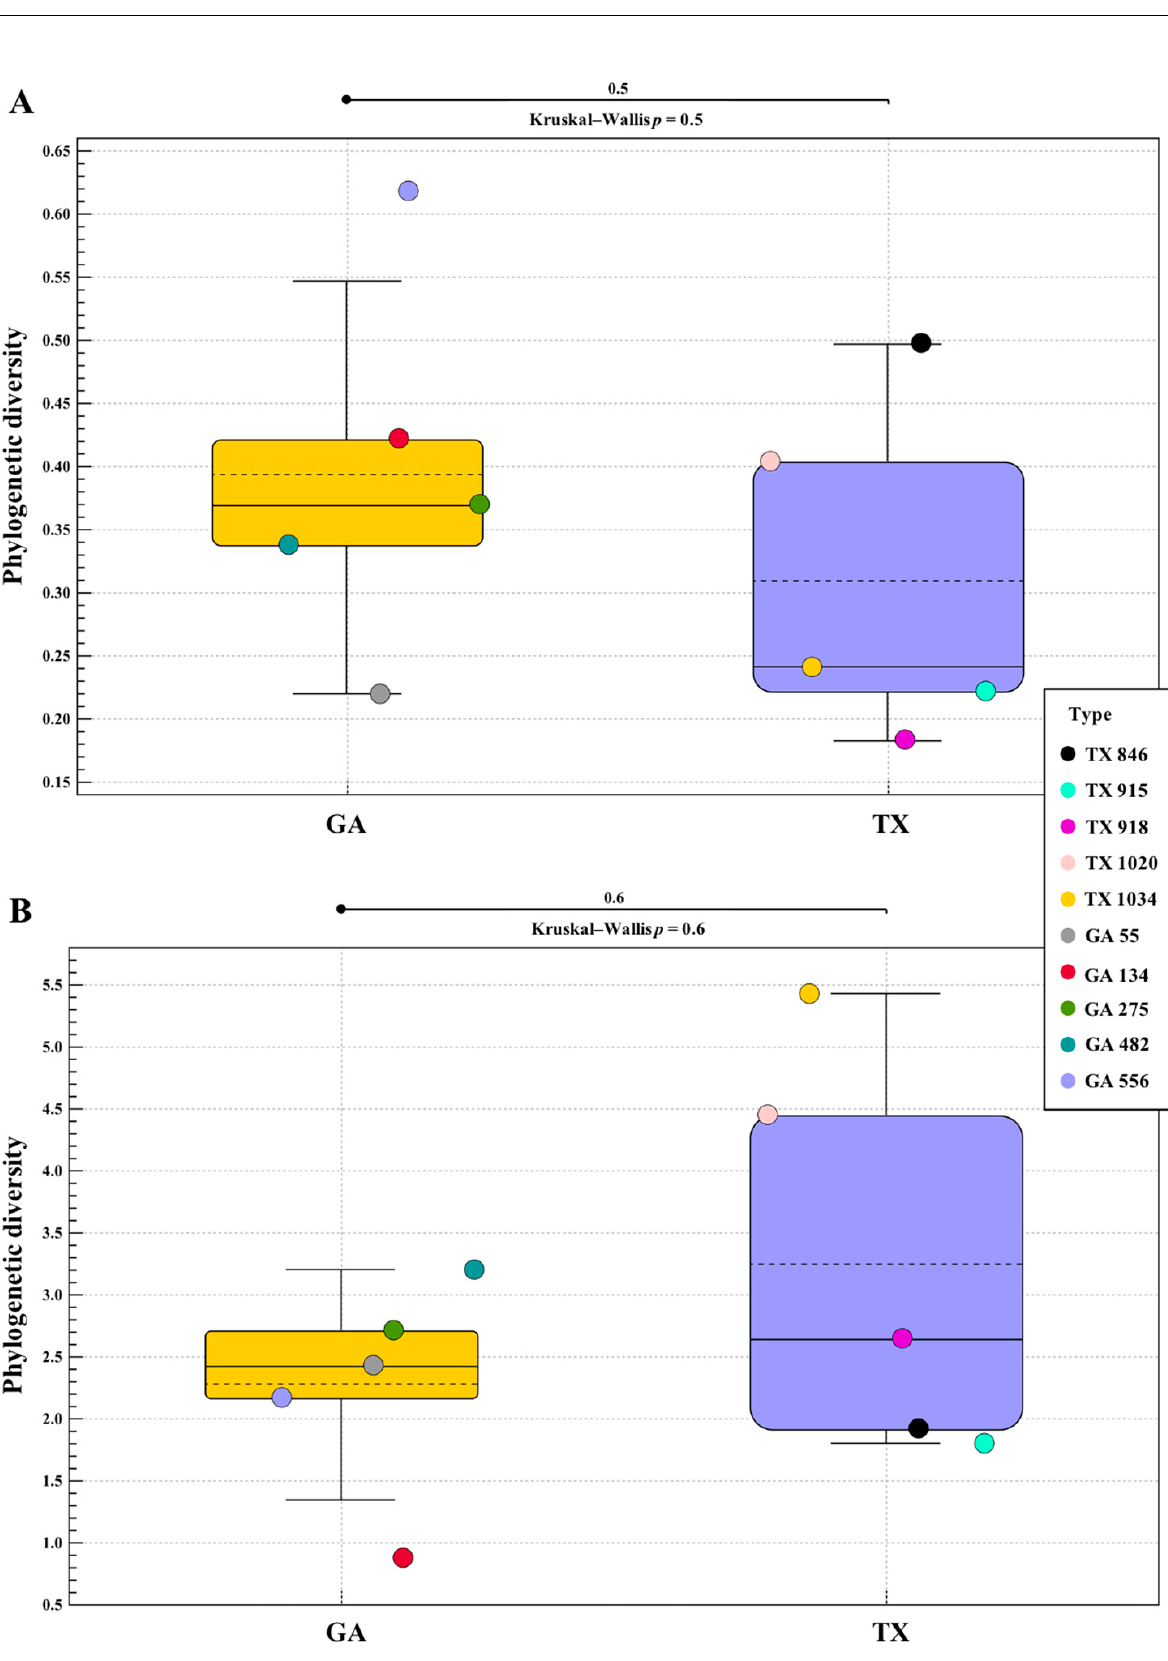
Figure 2. 16S and ITS Phylogenetic Alpha Diversity. Phylogenetic alpha diversity of bacterial ( A ) and fungal ( B ) populations in seedlings of pecan grown from seed of the same controlled ‘Lakota’ × ‘Oaxaca’ cross from trees in Texas (TX) and Georgia (GA).